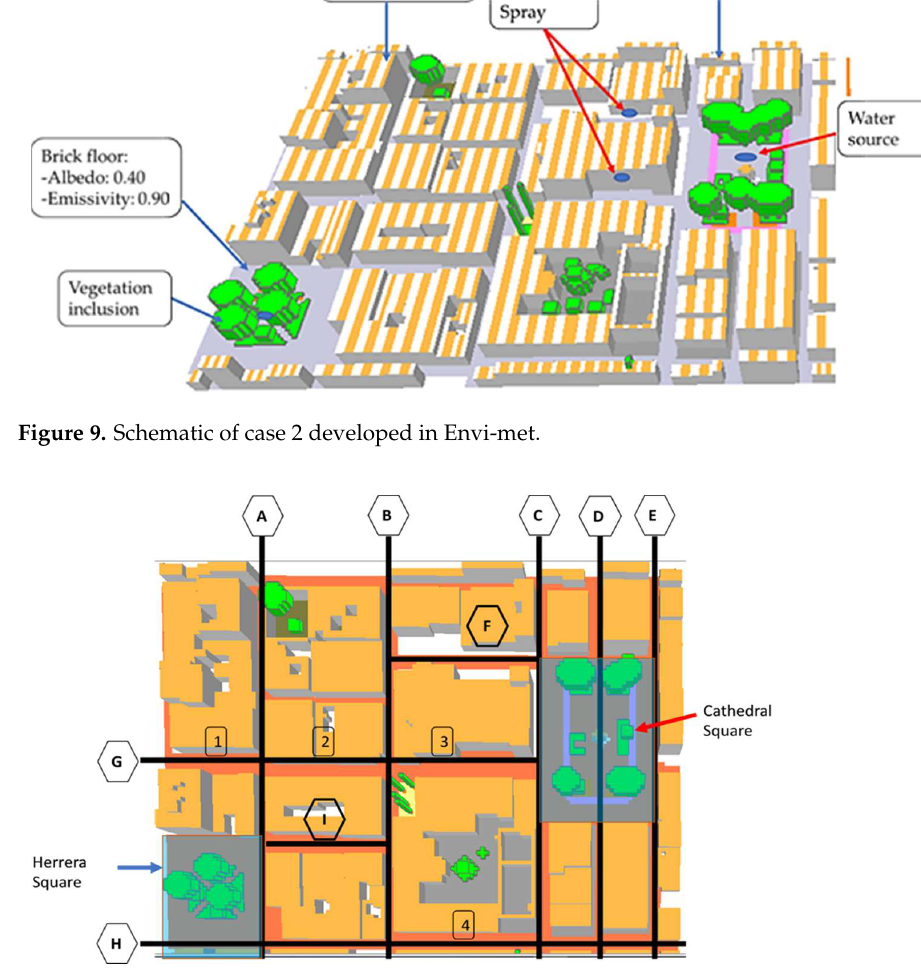
Figure 9. Schematic of case 2 developed in Envi-met.